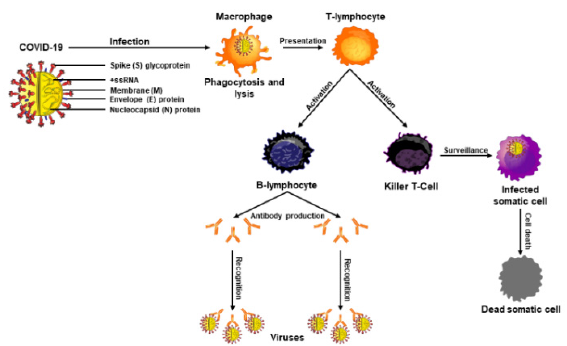
Figure 2. Schematic representation of a COVID-19 virus and its different components, i.e., spike (S), membrane (M), nucleocapsid (N), envelope (E), and RNA structure (+ssRNA). Shown is a proposed mechanism of COVID-19 infection and resultant immune response, including parts from the innate and adaptive immune system. COVID-19 virus enters the body, then macrophages from the innate response are able to ingest some viruses and destroy them from phagocytosis. This releases viral components and antigens, which, in turn, activate the adaptive immune response through T- and B-lymphocytes creating specialized killer T-cells and specific antibodies to combat COVID-19 infections and kill the cells already infected with the virus.